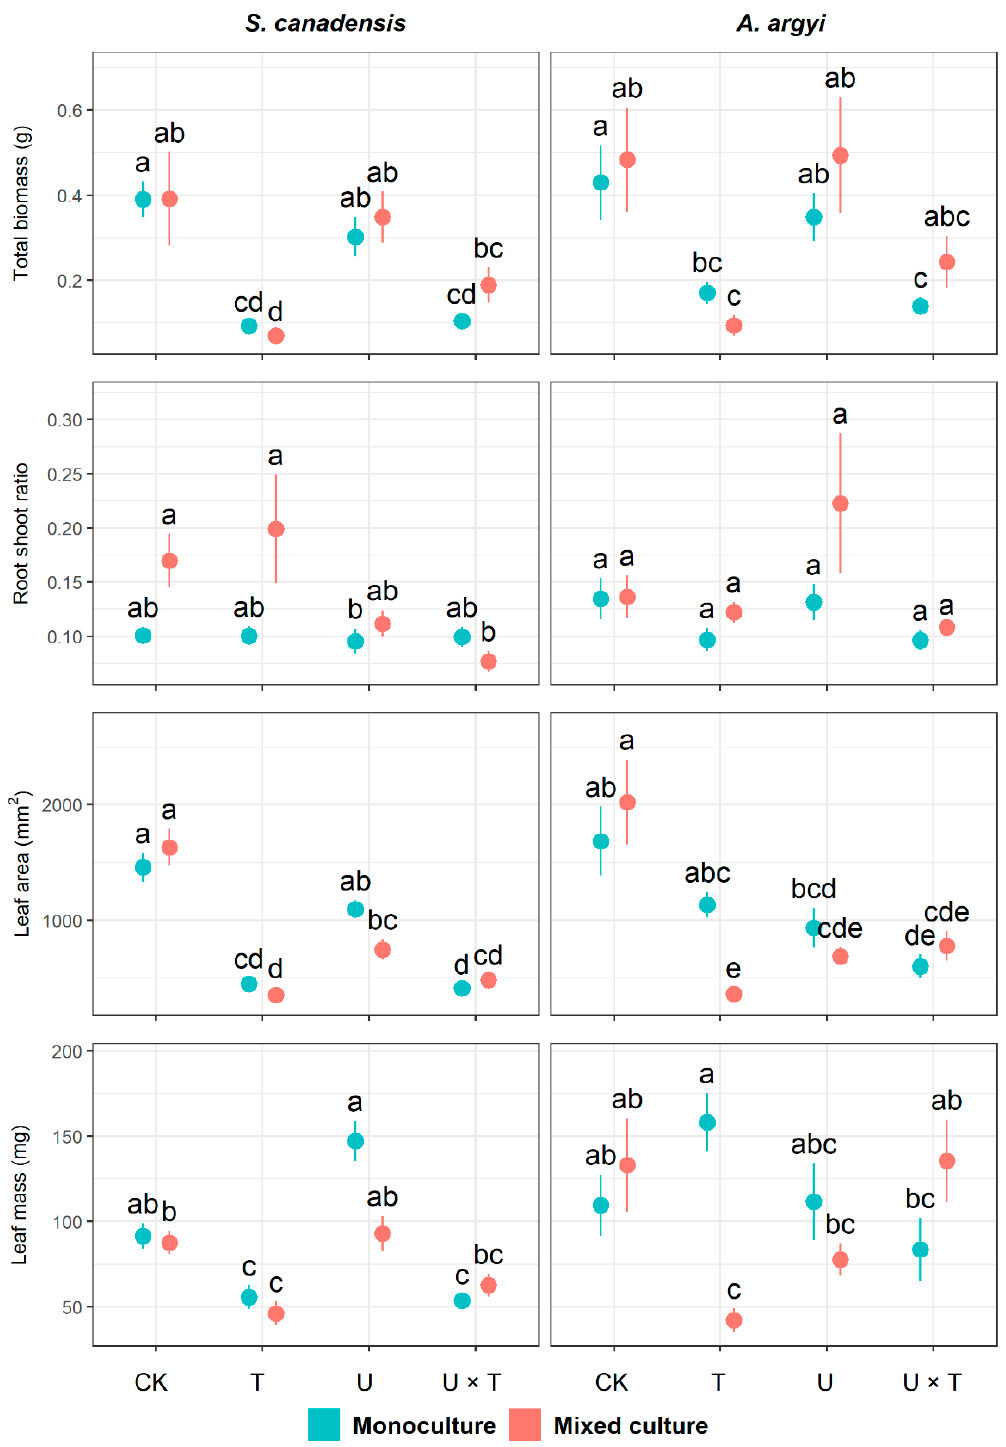
Figure 1. Effects of temperature and UV light on growth traits of the invasive Solidago canadensis and the co-occurring native species, Artemisia argyi, across plant communities (i.e., invasive species only, native species only, and mixed community). Each plant community was grown under four different treatments: ambient temperature and ambient UV light (control group, CK), warming and ambient UV light (T), ambient temperature and high UV (U), and high UV and warming (U × T). The solid data points represent the arithmetic mean, and the bars indicate the standard error (±SE). Significant differences ( p < 0.05) among treatments are denoted by different letters above the data points.